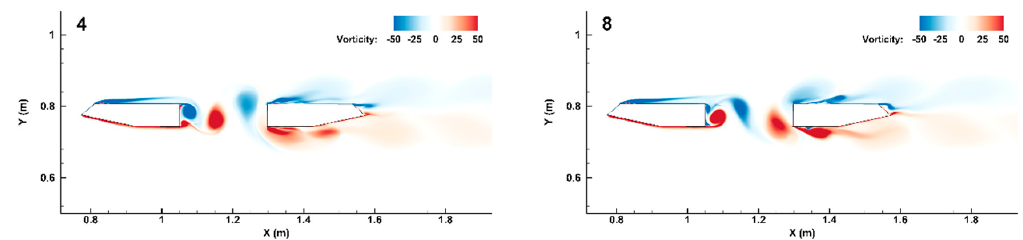
Figure 7. Vorticity contour plots of the eight time instances in one vortex shedding period for the case of AoA = + 0.1 ◦ .